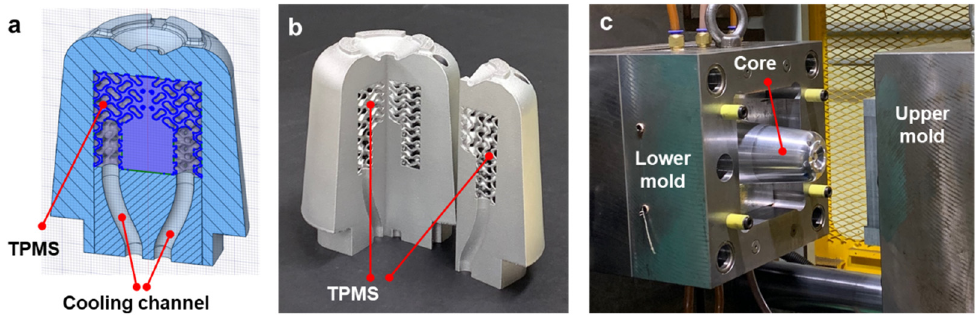
Figure 13. Additively manufactured metal mold containing the TPMS structure: ( a ) Sectional configuration of the upper core. ( b ) Additively manufactured upper core (sliced sample for verification of inner TPMS structure). ( c ) Experimental setup for the injection molding experiment.